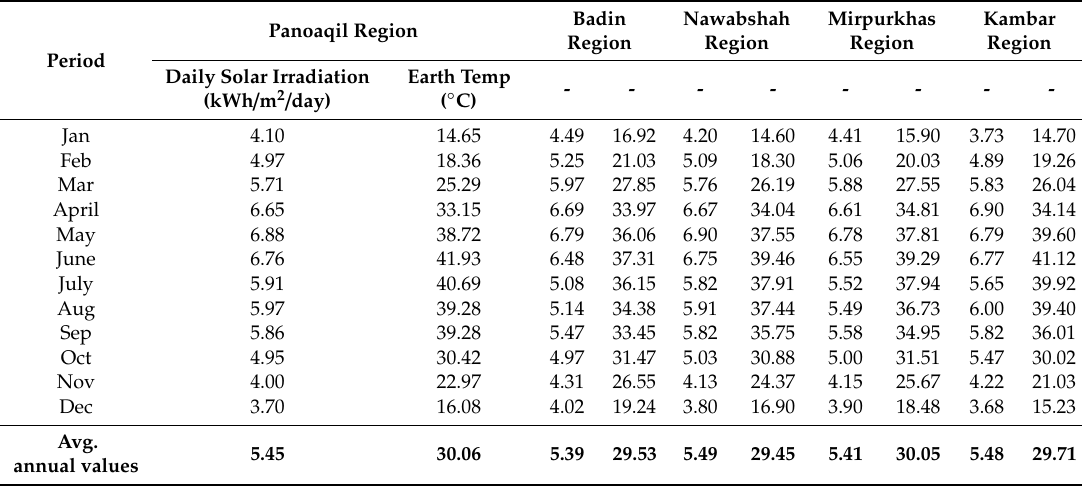
Table 2. Solar data for five regions of Sindh, Pakistan